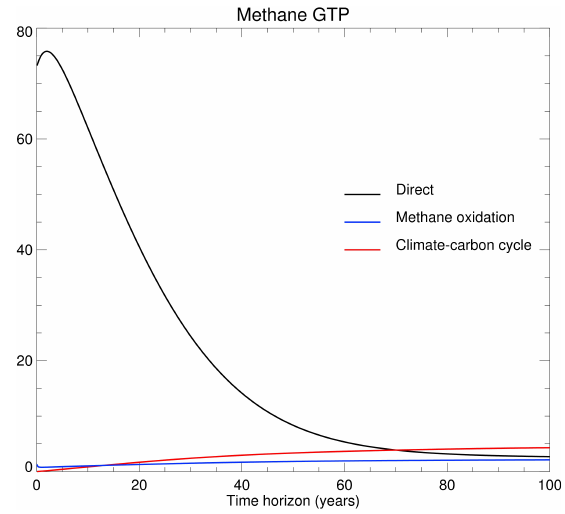
Fig. 9. The direct methane GTP (excluding ozone, sulphate and stratospheric water vapour), and additional contributions from CO 2 from two sources: the atmospheric oxidation of methane; and the impact of the methane-induced temperature change on the carbon